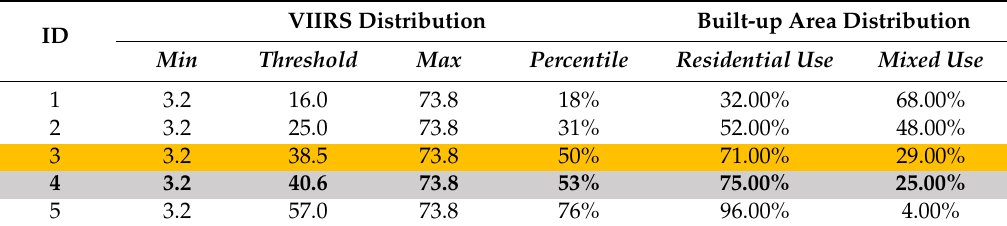
Table 2. VIIRS distribution thresholds (original 15 arc-sec grid) and corresponding building use distribution ratios (grey indicating selected best-matching threshold, orange indicating 50% threshold for comparison).